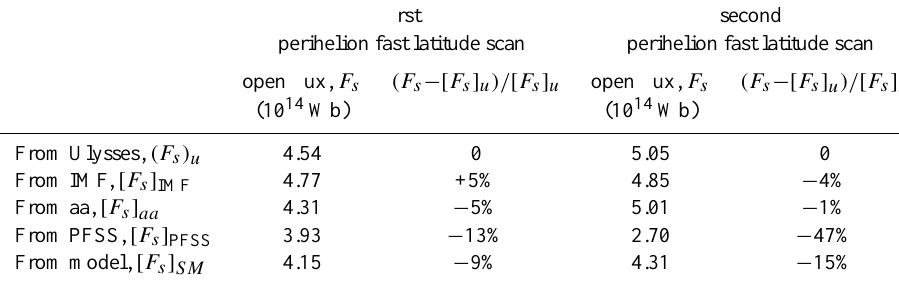
Table 1. Estimates of the open solar flux during the first and second perihelion passes of Ulysses. first second perihelion fast latitude